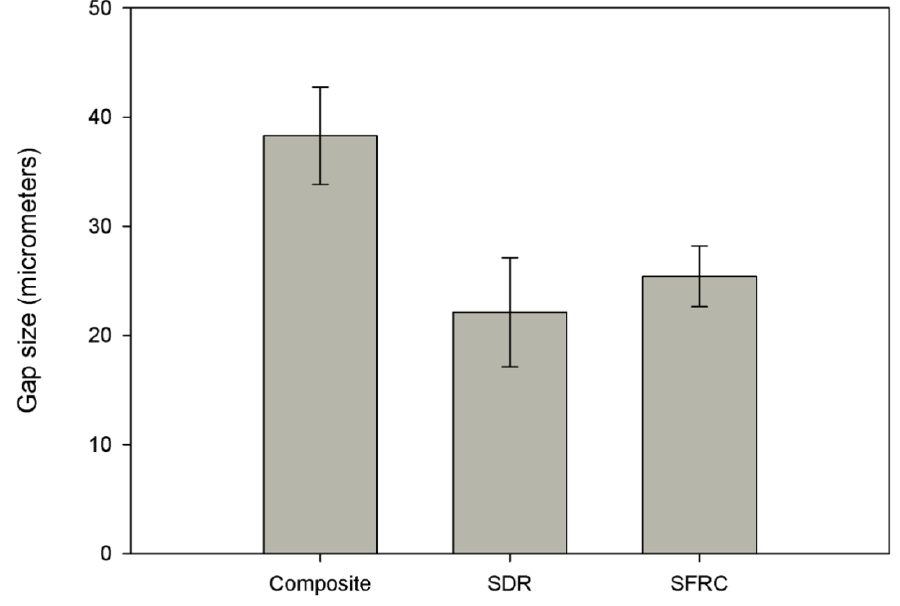
Figure 4. Column plots of gap size by group (group mean +/ −